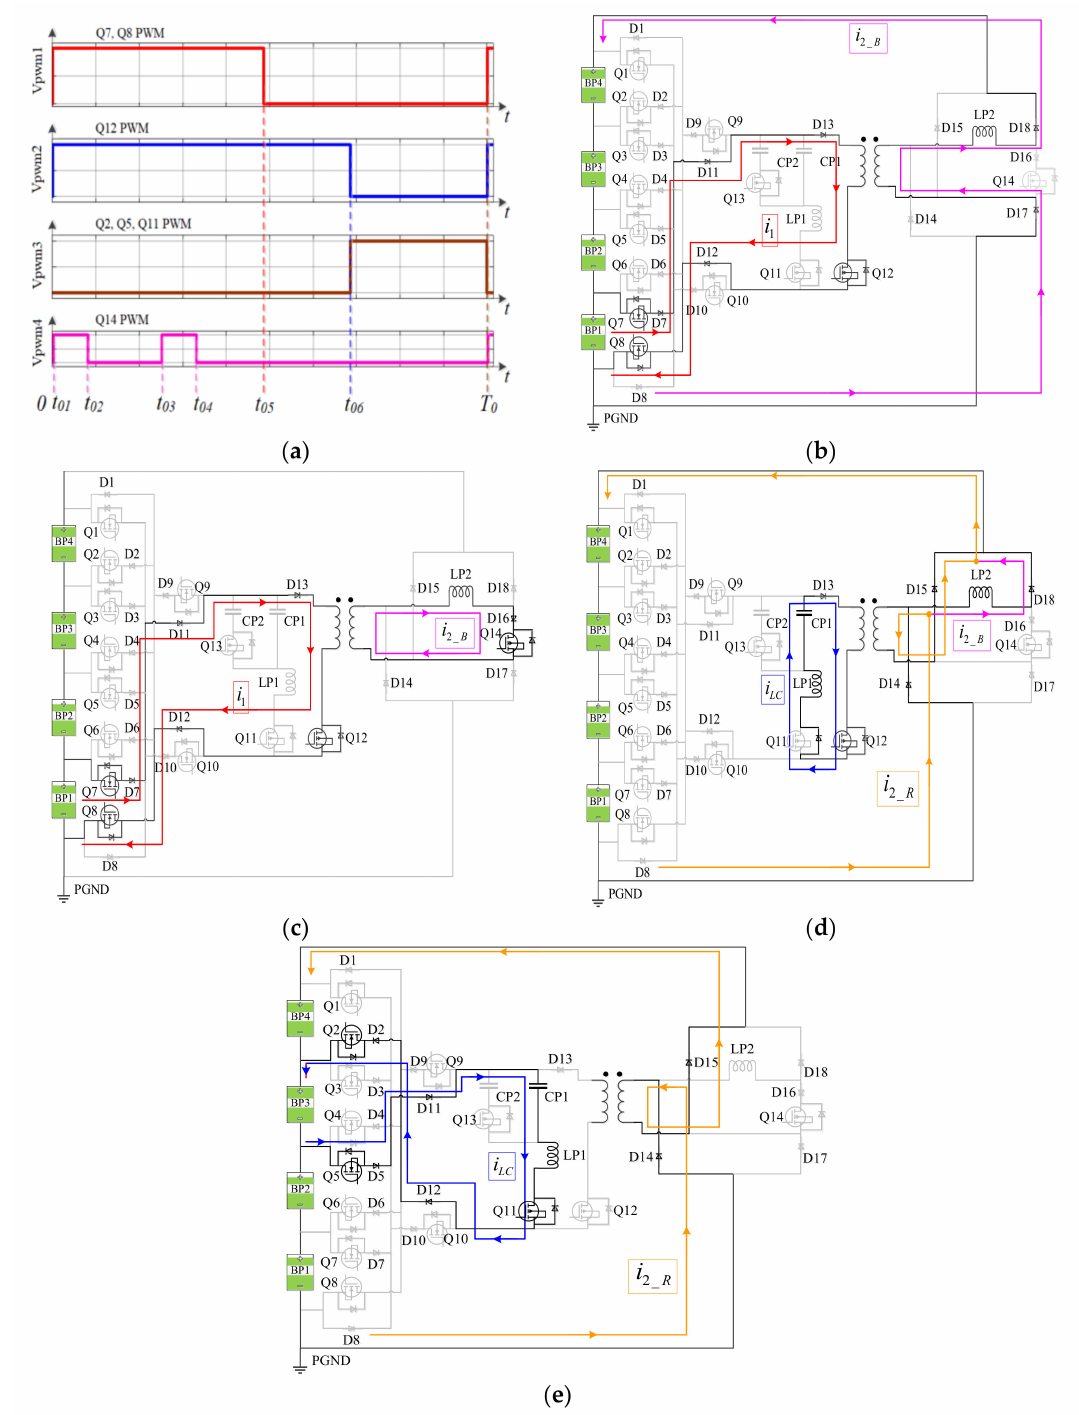
Figure 2. Operating principles of pack-to-pack-group and pack-to-any-pack (P2PG&AP) mode. ( a ) PWM wave sequence diagram of P2PG&AP mode. ( b ) State I,III and V. ( c ) State II,IV. ( d ) State VI. ( e ) State